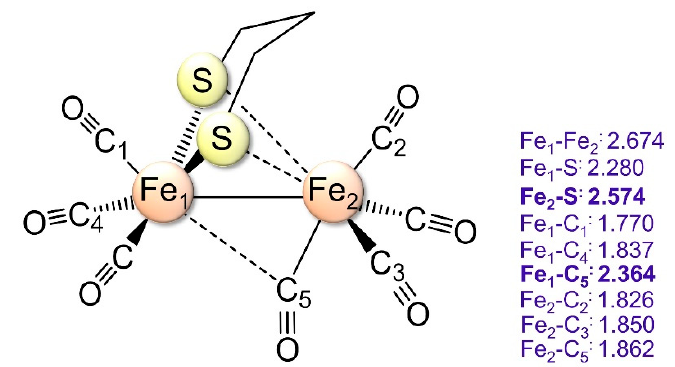
Figure 9. DFT-optimized geometry of the 2 a + –CO 1 2 A ″ excited state at DFT level imposing the proper MO occupancy. Distances in Å.